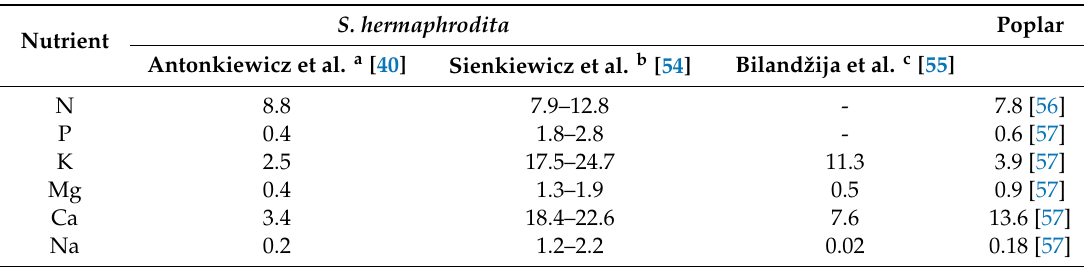
Table 3. Reported values of the nutrient content of harvested stems and branches (g kg − 1 DM) of S. hermaphrodita compared to poplar short rotation